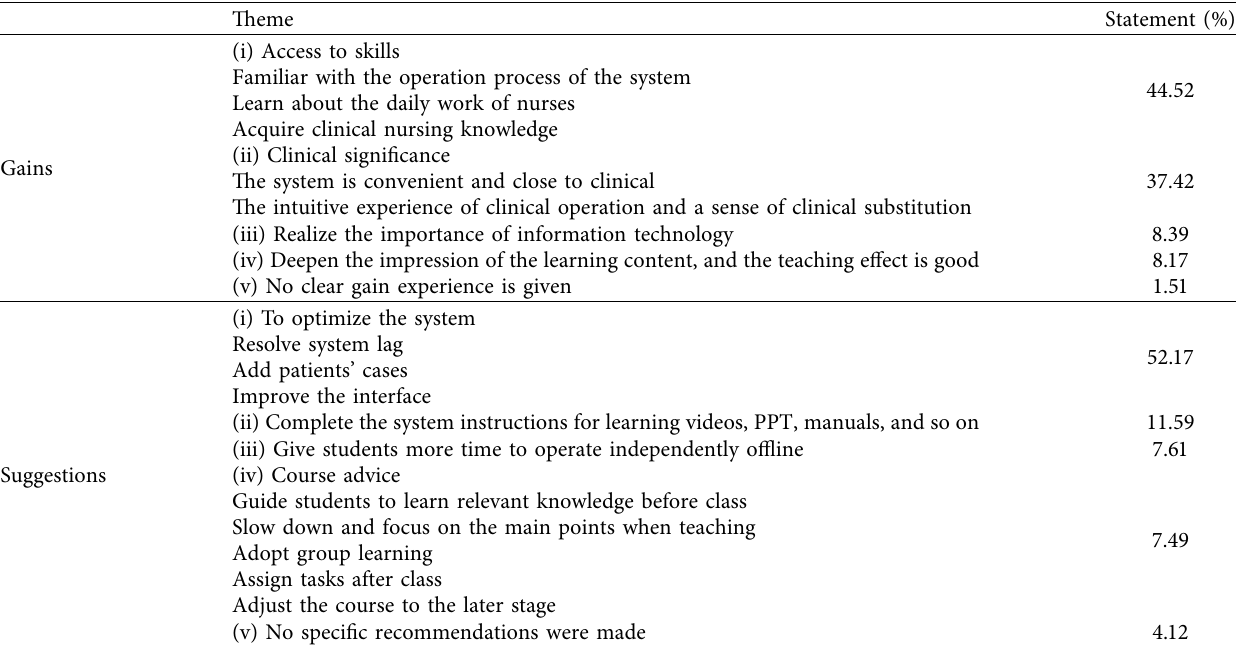
Table 2: Nurse students’ benefts and suggestions for the system’s teaching.